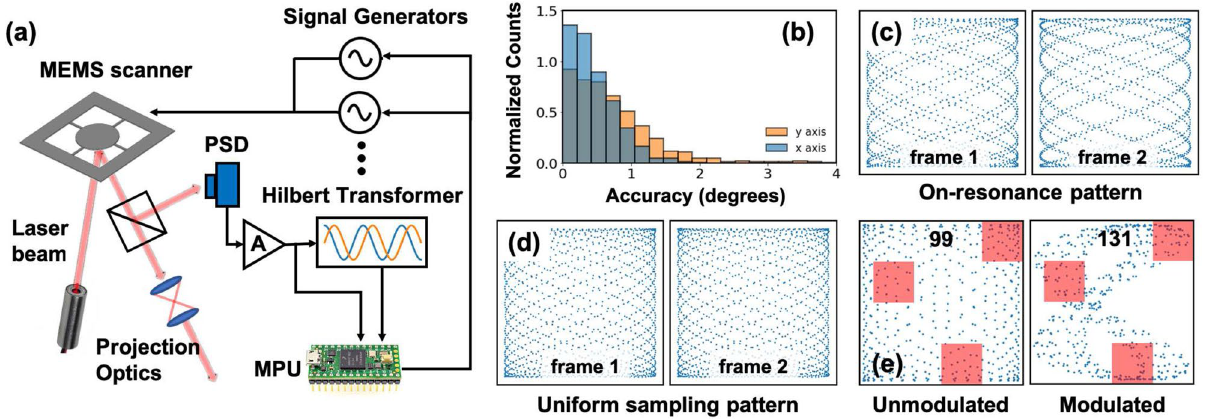
Figure 4. ( a ) Schematic of experimental set up for phase controlled resonant scanning. ( b ) Phase control accuracy of proposed hardware. ( c ) Recorded on-resonance scanning pattern, for two successive frames. ( d